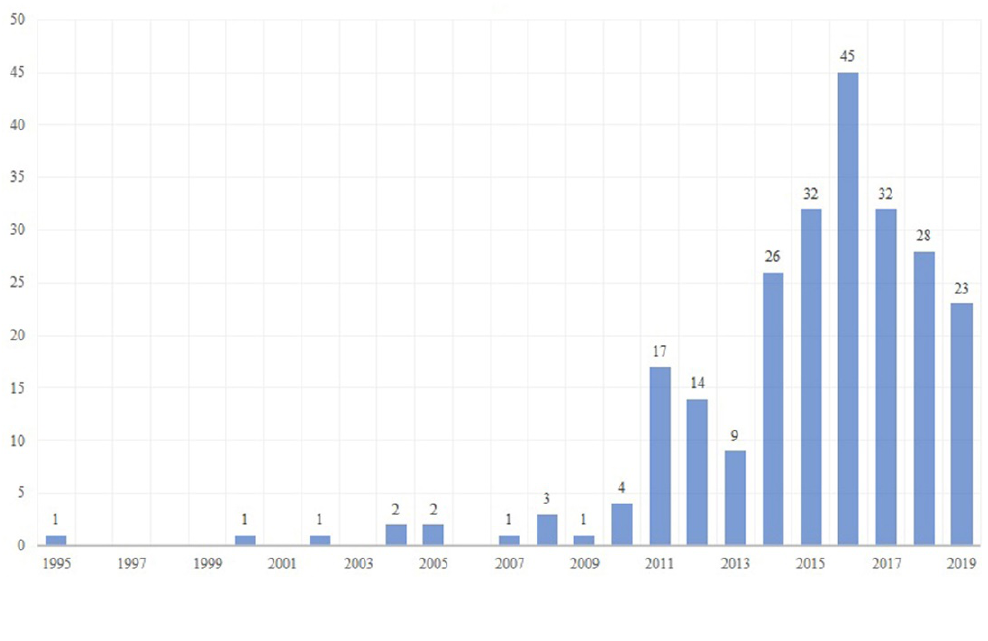
Figure 2 Growth in the number of publications over